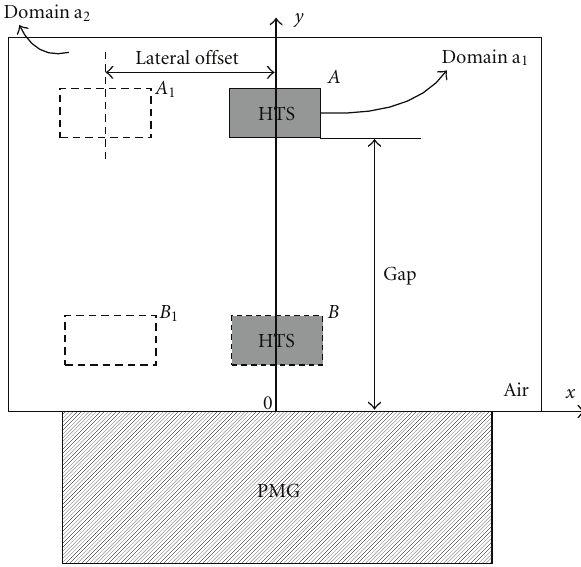
Figure 2: The cross section of bulk HTS-PMG levitation